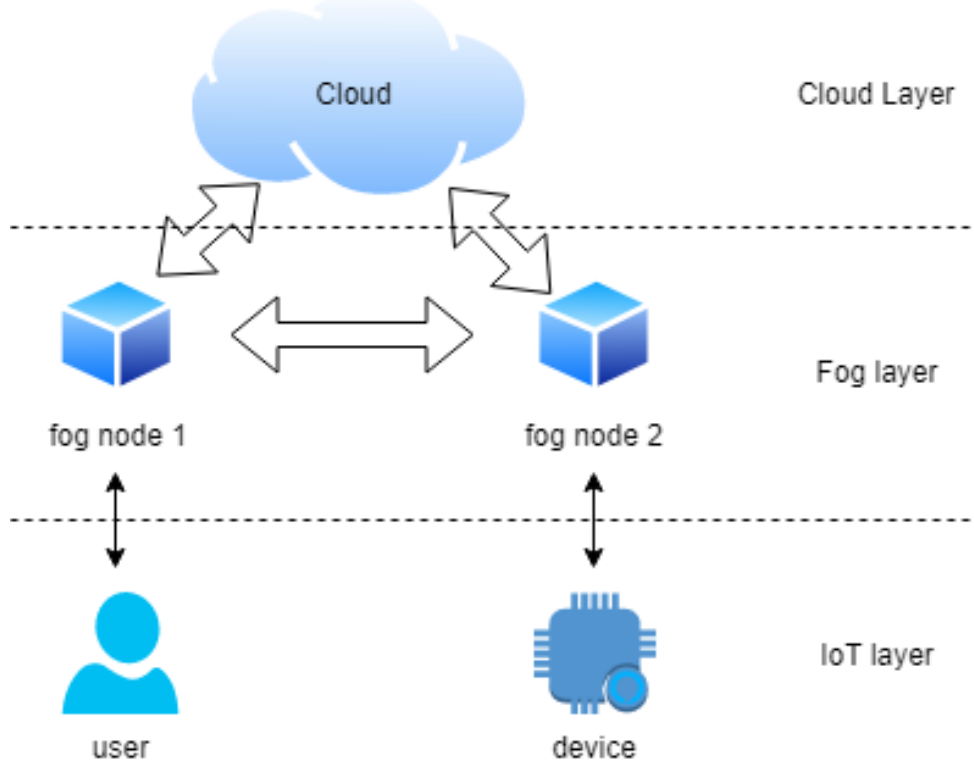
Figure 1. A generic fog architecture for edge-based IoT